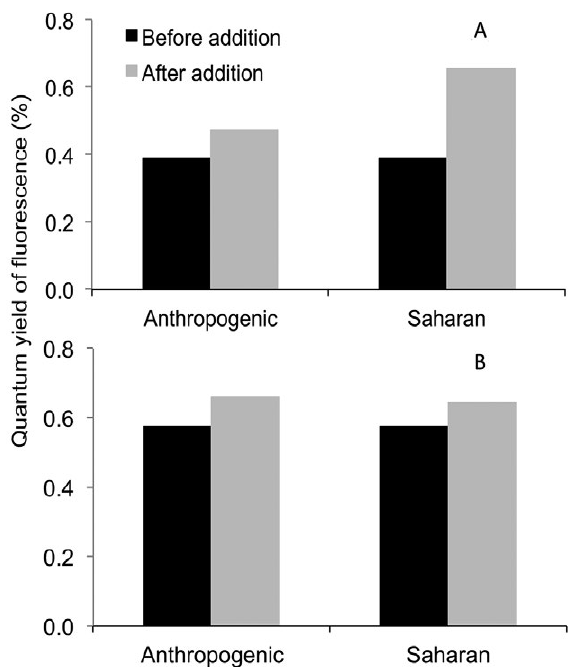
Fig. 6. – Fluorescence quantum yield at 340 nm [ Φ (340)] before and after anthropogenic and Saharan dust addition. A, BLSp experi- ment; B, BCNSp experiment. The [ Φ (340)] is expressed in percent- age